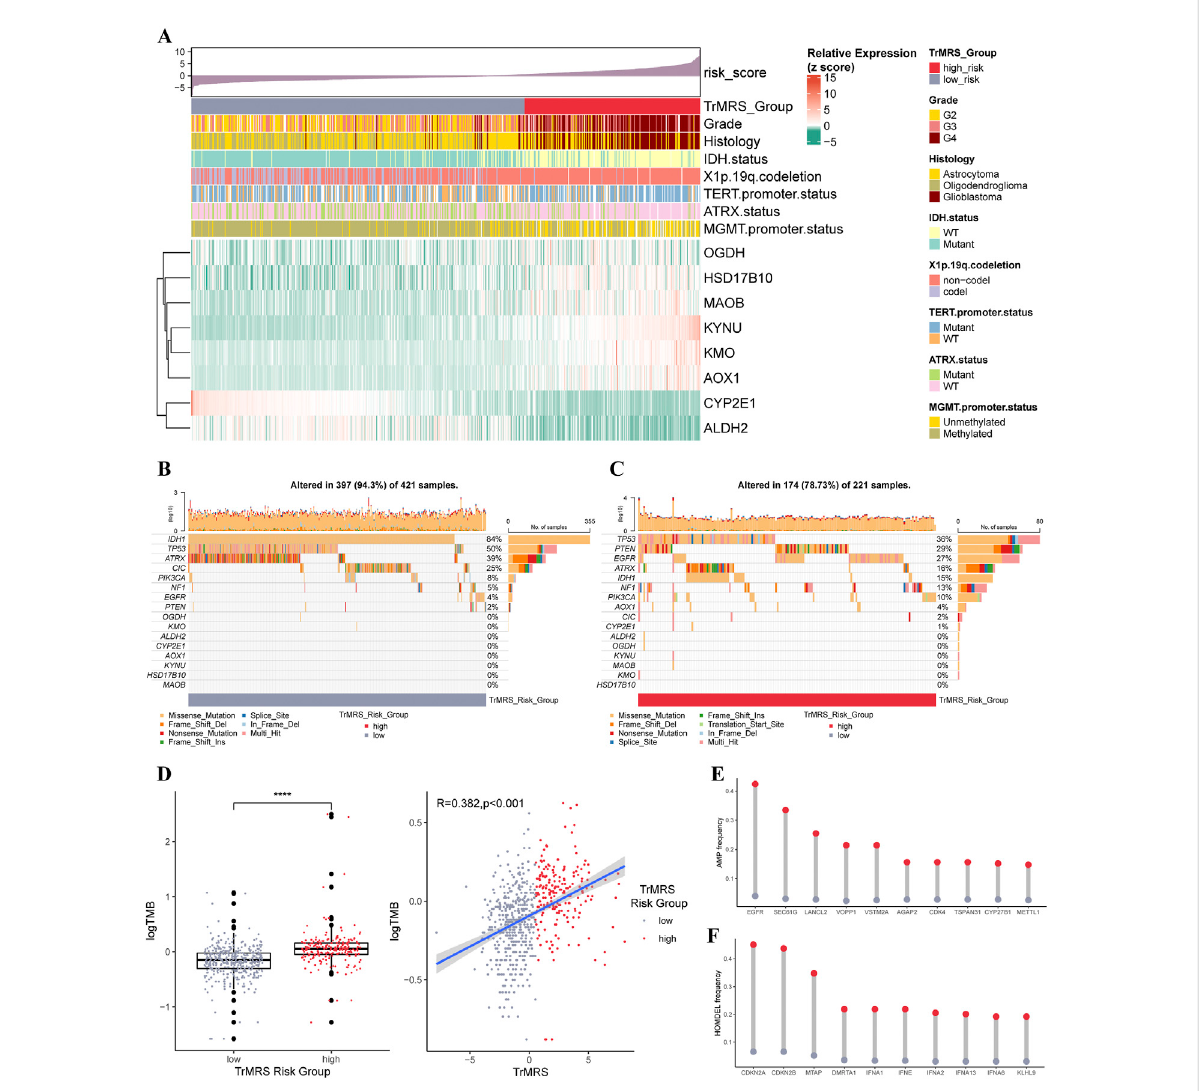
FIGURE 5 Gene mutations and copy number variations of the two risk groups. (A) Expression level of eight essential TrMGs and its relationship with clinicopathological features. (B) Genemutations ofeight essential TrMGs and top eight frequentlymutatedgenes inTrMRSlow-risk group ( N = 429) and (C) high-risk group ( N = 226). (D) Difference in tumor mutation burden between two TrMRS risk groups and its correlation with TrMRS. (E) Difference in top 10 frequent gene ampli fi cation between two risk groups. (F) Difference in top 10 frequent gene homozygous deletion between two risk group. * p < 0.05; ** p < 0.01; *** p < 0.001; **** p <